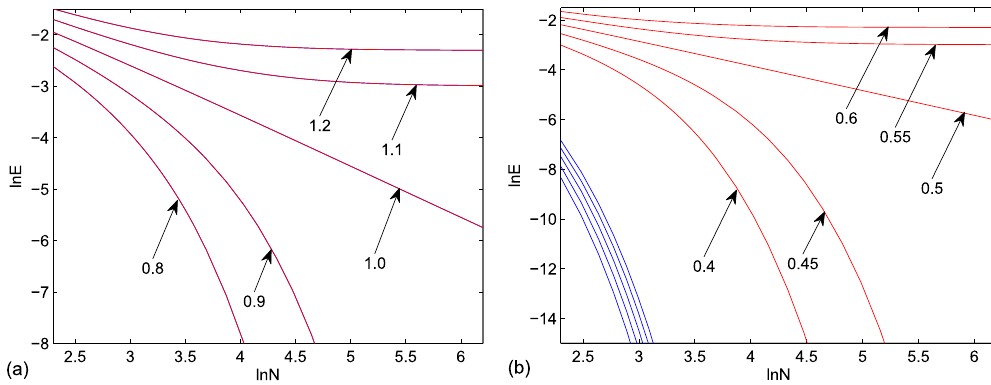
Figure 4. Positive energy levels related to zero modes for N -site systems ( a ) h a and ( b ) h b with typical values of λ , calculated by exact diagonalization. ( a ) Two positive levels of h a are degenerate, which turns to vanish for λ < 1, is a straight line for λ = 1, and converge to a finite value for λ > 1. ( b ) One of two positive levels (blue) turns to vanish for given λ , while another level has the similar behavior as that in ( a ) when λ are around